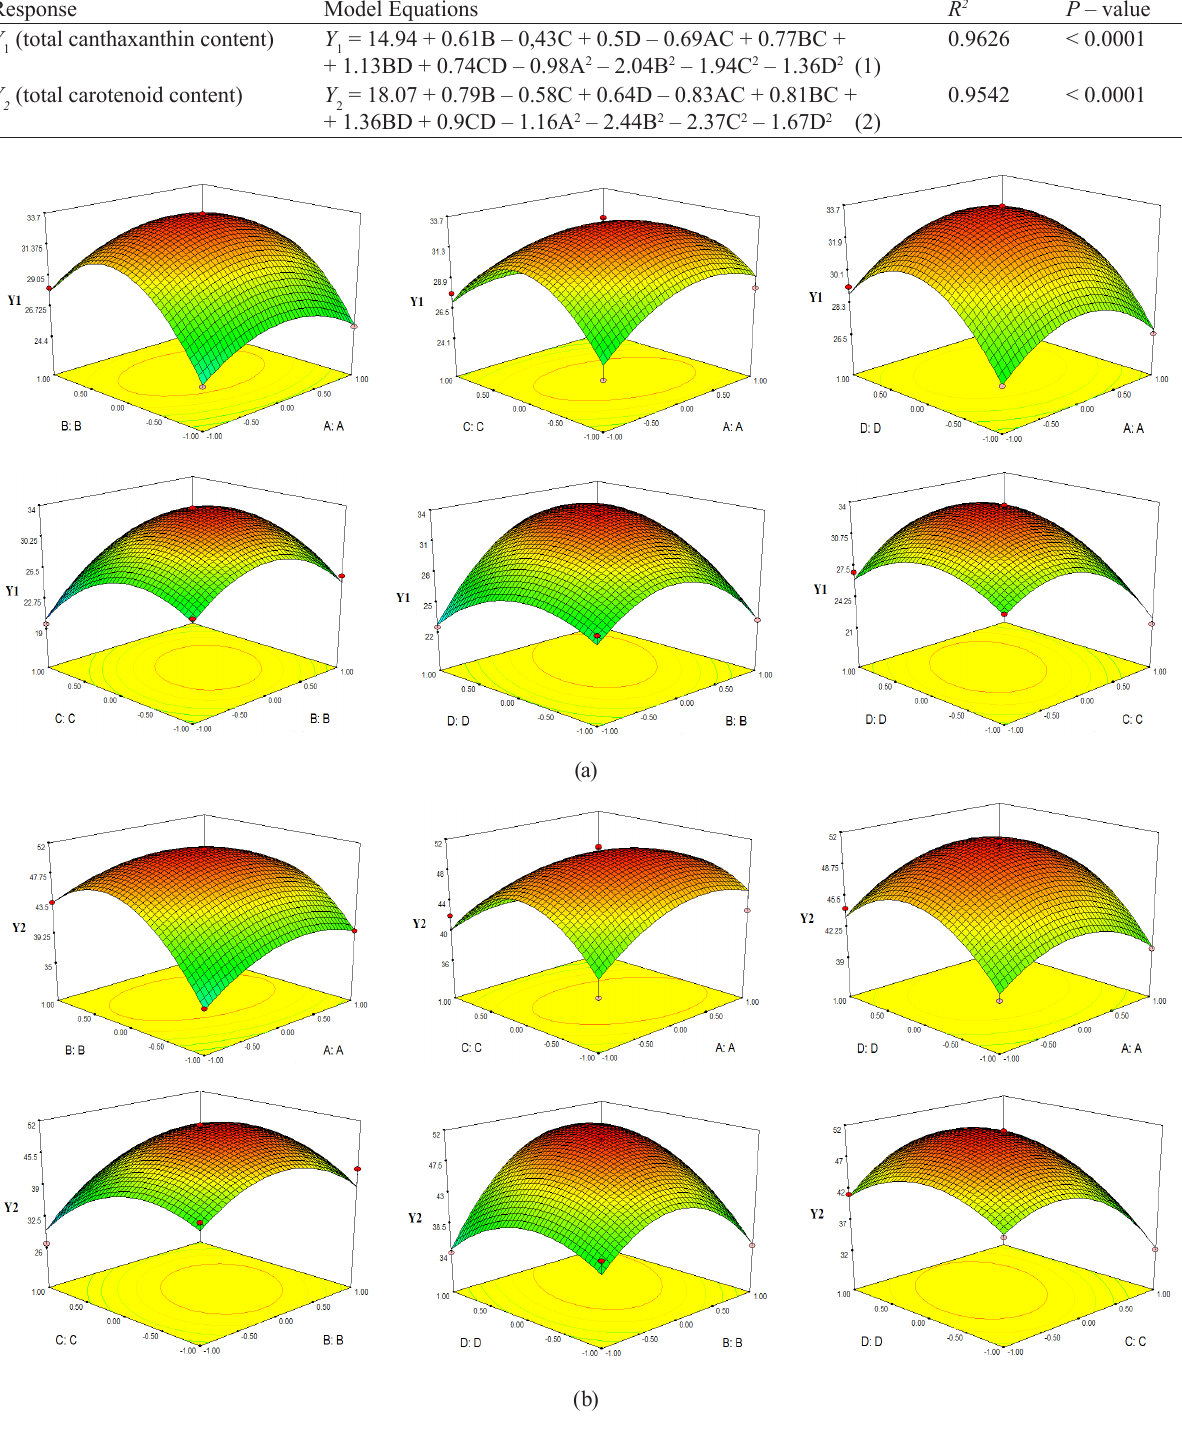
Figure 3 Response surface of canthaxanthin content (a) and total carotenoid content (b) content increased from 6.4 to 15.0 mg/g, and total carotenoid content increased from 9.3 to 18.2